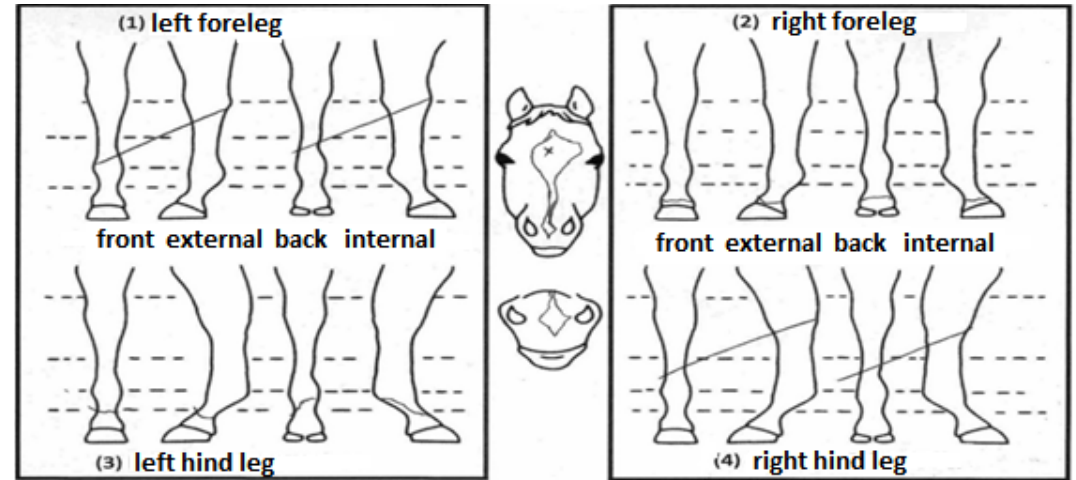
Figure 1. Official outline diagram from ABQM containing a graphic representation of the whorls’ position and number (authors’ own translation).